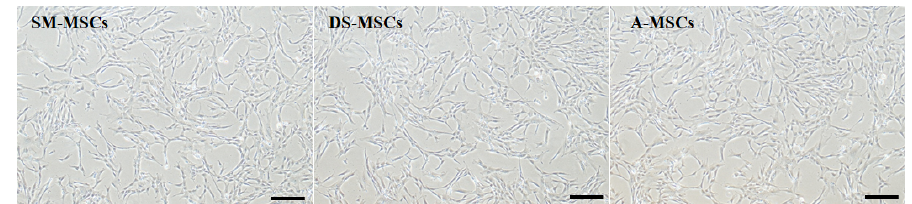
Figure 1. Cellular morphology of mesenchymal stem cells (MSCs) derived from skeletal muscle (SM-MSCs), dermal skin (DS-MSCs), and adipose tissue (A-MSCs) was observed at passage three by phase-contrast microscope. Scale bar = 100 µm.